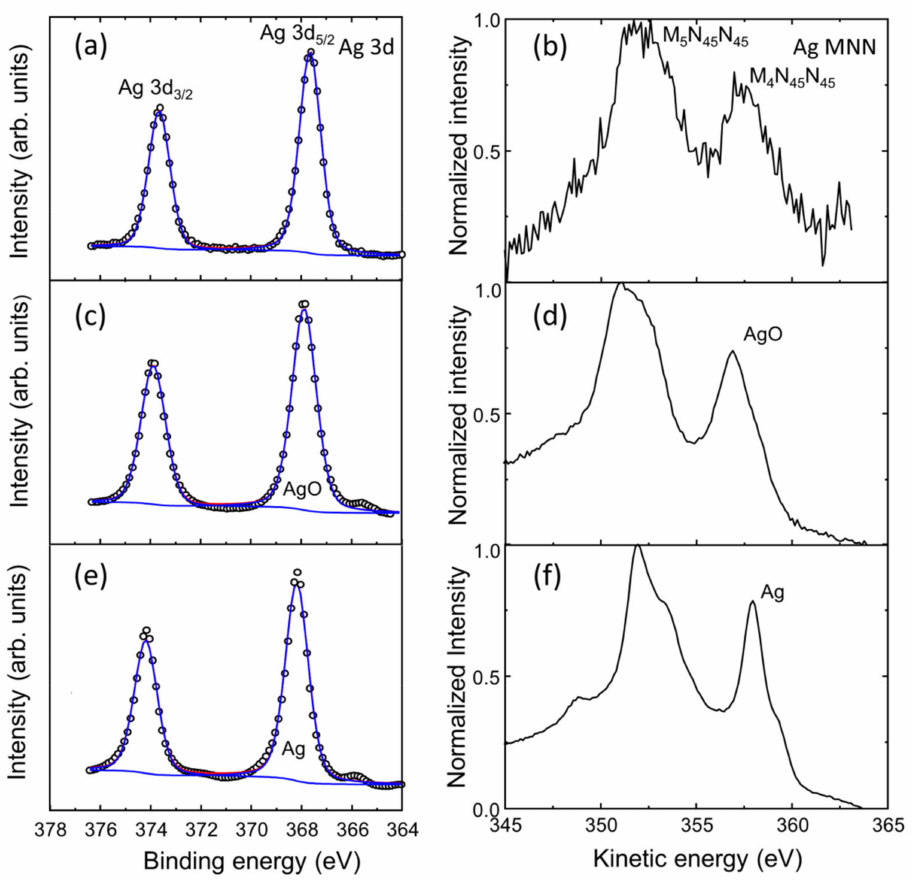
Figure 14. Evolution of high-resolution XPS Ag 3d and Ag MNN region spectra for a vacuum- thermal-evaporated silver layer with a nominal thickness d Ag = 80 nm. ( a , b ) Surface study of the sample after the annealing step during the SSD process applying the constant temperature region program depicted in Figure 1 at T A = 500 ◦ C and for t A = 26 min. Surface analysis of a silver layer with a nominal thickness d Ag = 80 nm as-grown (without annealing): ( c , d ) and ( e , f ) before and after 1 min surface bombardment with Ar + (~5 nm/min etching rate), respectively. Experimental data are presented by small open circles, while superimposed solid lines are the result of peak-fitting